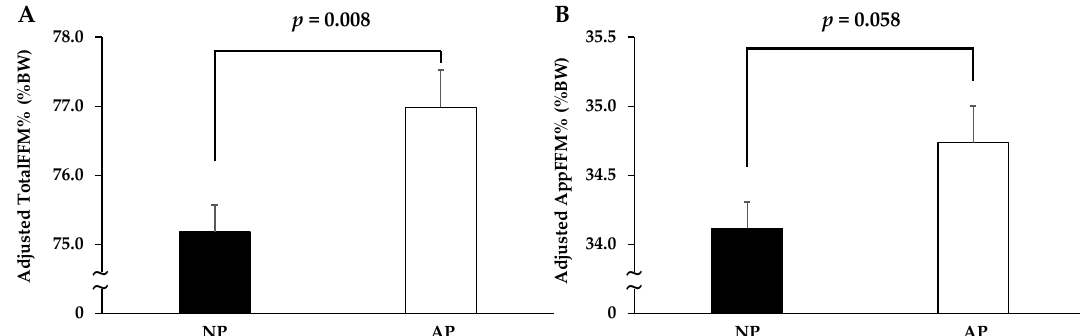
Figure 4. Comparisons of adjusted body compositions between AP ( ☐ : n = 83) and NP ( ■ : n = 153) groups with total protein intake more than RDA. After adjusting energy intake with residual methods 7 , the subjects were separated into the two groups: the AP group, achieving over 0.24 g/kg BW of protein intake at all three meals; and the NP group, not achieving 0.24 g/kg BW of protein intake in at least one meal. Values are expressed as means ± SE, and adjusted for age, sex, drinking habit, smoking habit, living condition (alone or family), PSQI, MEQ, and IPAQ scores. Abbreviations: RDA, recommended dietary allowance; BW, Body Weight; PSQI, Pittsburgh Sleep Quality Index; MEQ, Morningness–Eveningness Questionnaire; IPAQ, International Physical Activity Questionnaire.